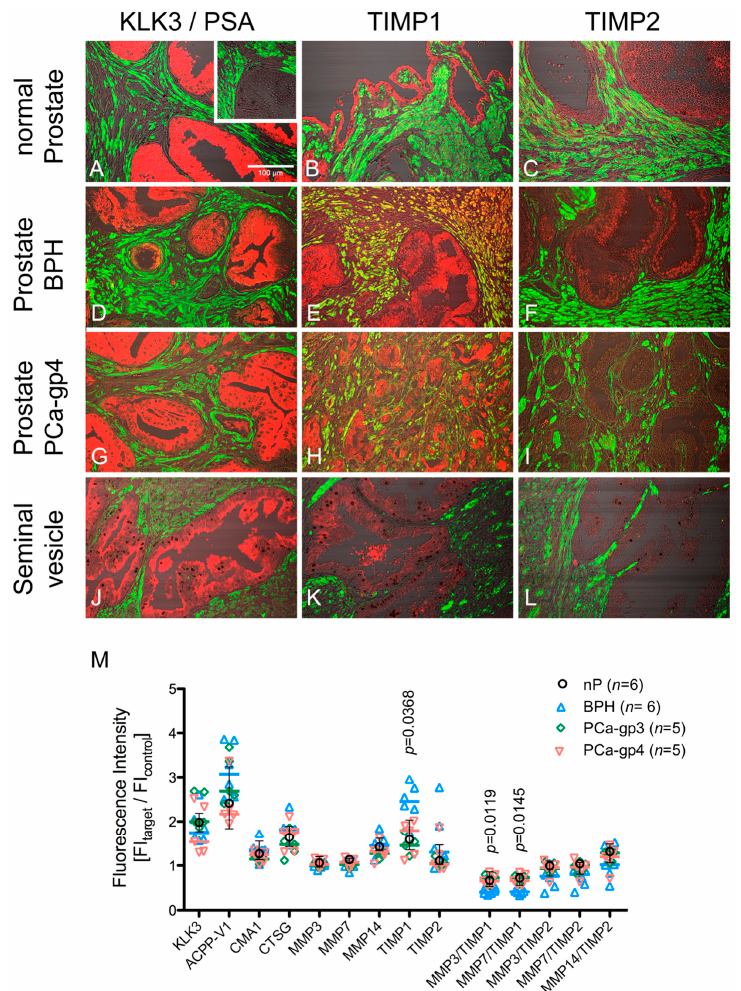
Figure 3. Protein expression analysis using confocal immunofluorescence imaging. Immunohistochemical tissue expression of selected proteases and tissue inhibitors of metalloproteinases. ( A – L ) Confocal images demonstrating tissue distribution of target proteins (red); alpha-smooth muscle cell actin (aSMCA; green). Phase contrast images are merged for tissue structure. Immunofluorescence (IF) of KLK3, TIMP1 and TIMP2 in normal prostate ( A – C ), BPH ( D – F ); PCa Gleason pattern 4 (PCa-gp4; G – I ) and seminal vesicle ( J – L ). Note the marked upregulation of TIMP1 in BPH especially in SMC ( E ; orange colored cells) and the downregulation of TIMP1-IF in the smooth muscle cells of PCa-gp4 ( H ); TIMP2-IF is almost completely lost in PCa-gp4 tissue ( I ); KLK3-IF in seminal vesicle was low, TIMP1-IF moderate and TIMP2-IF was very low ( J – I ); Scale bar indicating 100 µ m in ( A ) applies to all micrographs; staining control (inset in A ); ( M ) Scatter plot of fluorescence intensities; lines indicate medians. Normal prostate (black symbols) are depicted as median with interquartile range. p -Values are based on nonparametric Kruskal–Wallis test.